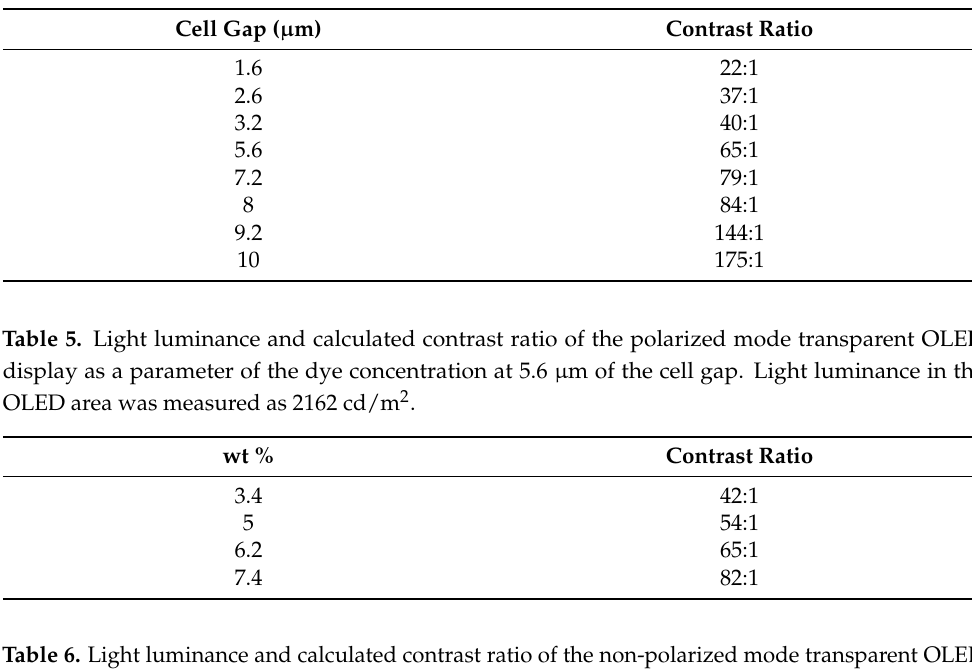
Table 4. Light luminance and calculated contrast ratio of the polarized mode transparent OLED display as a parameter of cell gap at 6.2 wt % of the dichroic dye concentration. Light luminance in the OLED area was measured as 2162 cd/m 2 .